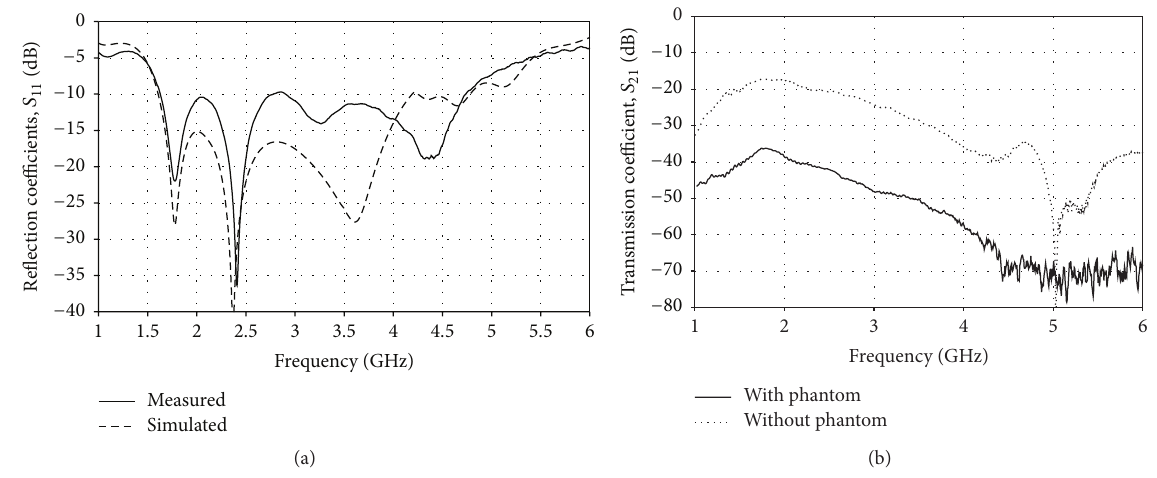
Figure 4: (a) Simulated and measured reflection coefficient of the double-ridged horn antenna designed for medical imaging. (b) Transmission coefficients of the antenna with and without breast phantom. Glycerin was used as the breast phantom material.